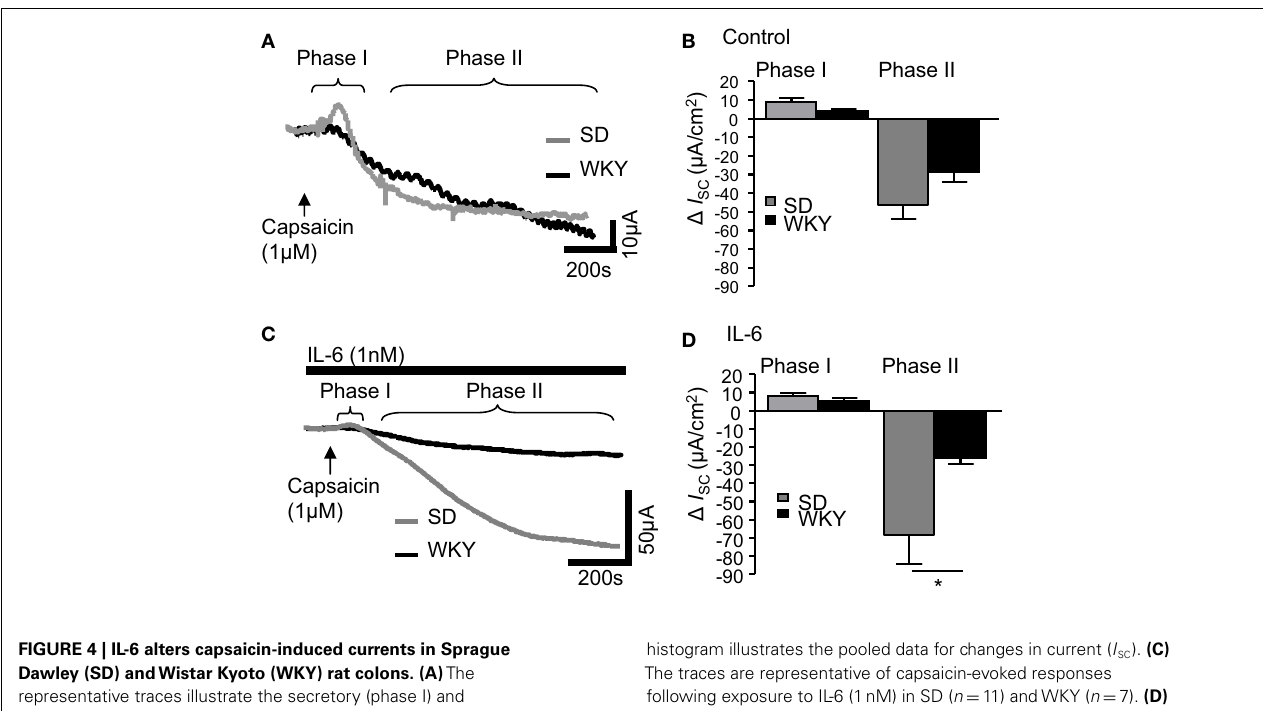
FIGURE 4 | IL-6 alters capsaicin-induced currents in Sprague Dawley (SD) andWistar Kyoto (WKY) rat colons. (A) The representative traces illustrate the secretory (phase I) and anti-secretory (phase II) responses to capsaicin (1 µ M) in control SD (gray line, n = 10) andWKY (black line, n = 10) distal colons. (B) The